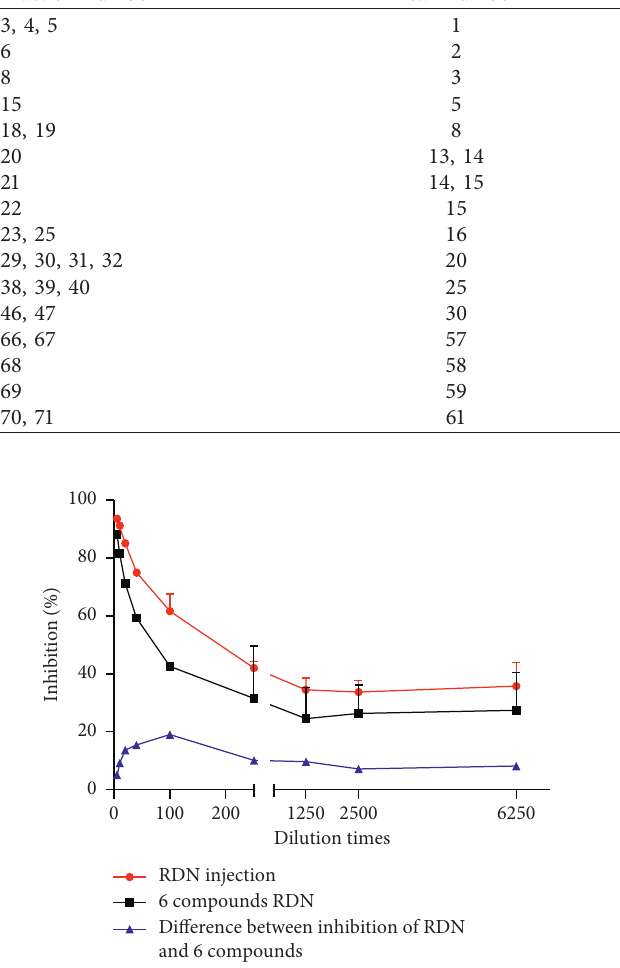
Table 3: The corresponding relationship between fraction number and peak number of the potential active components with NA inhibition. Fraction number Peak number